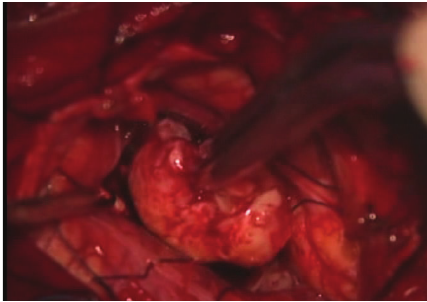
Figure 2: Intraoperative findings. The tumor in the vermis was totally removed. The mass appears yellowish, elastic, and hard with a clear boundary from normal